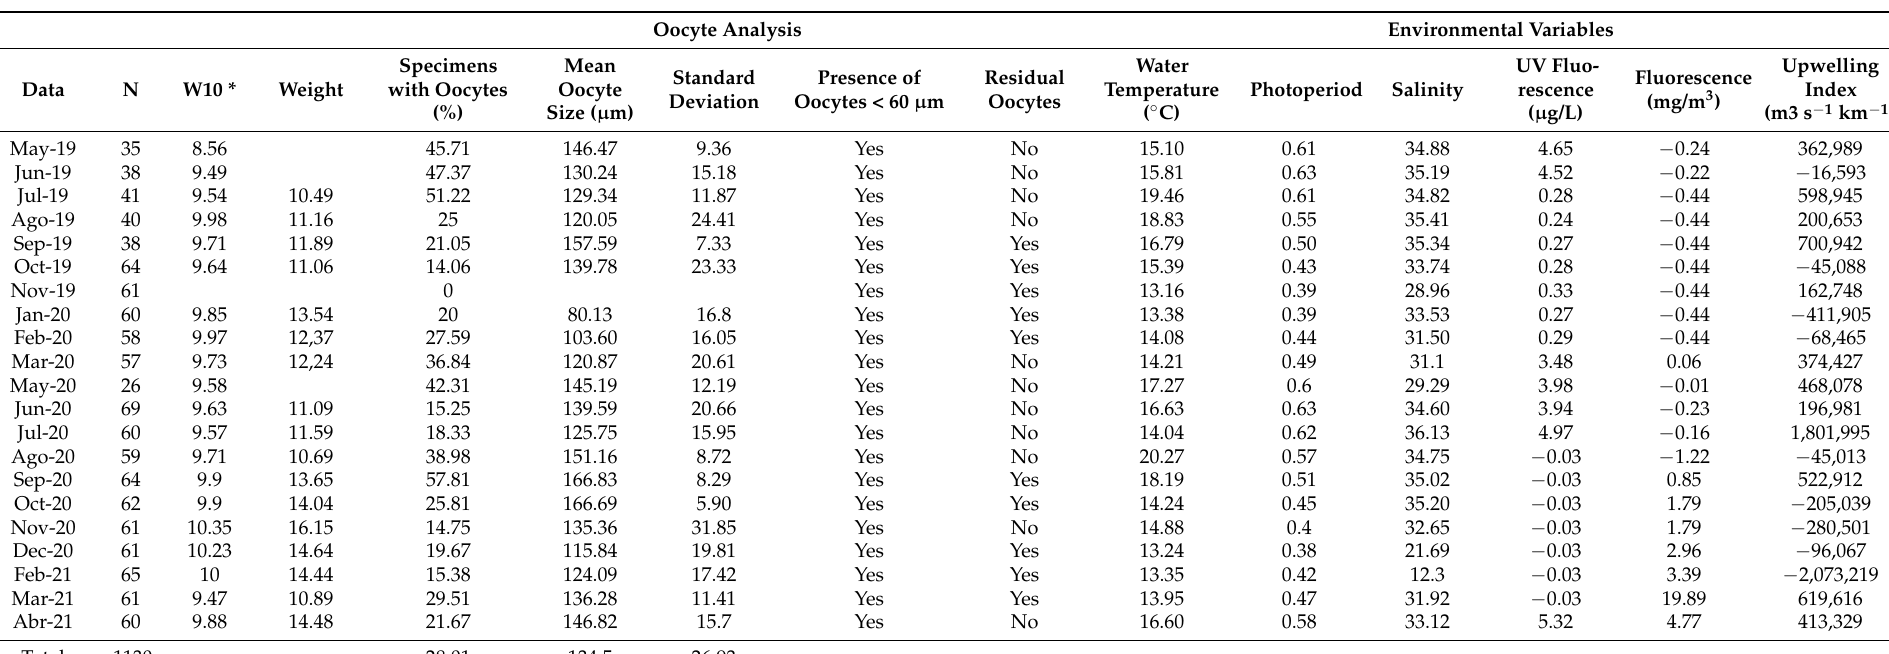
Table 1. Summary of the reproductive variables analysed for those specimens of Diopatra neapolitana showing oocytes in the coelom, as well as the environmental variables collected for the study area. Presence of oocytes < 60 µ m is shown as a qualitative indicator of the presence of oocytes at the beginning of the maturation stage. Residual oocytes refer to specimens that had oocytes but whose number was so low that their mean size could not be calculated. * The weight was measured only in complete